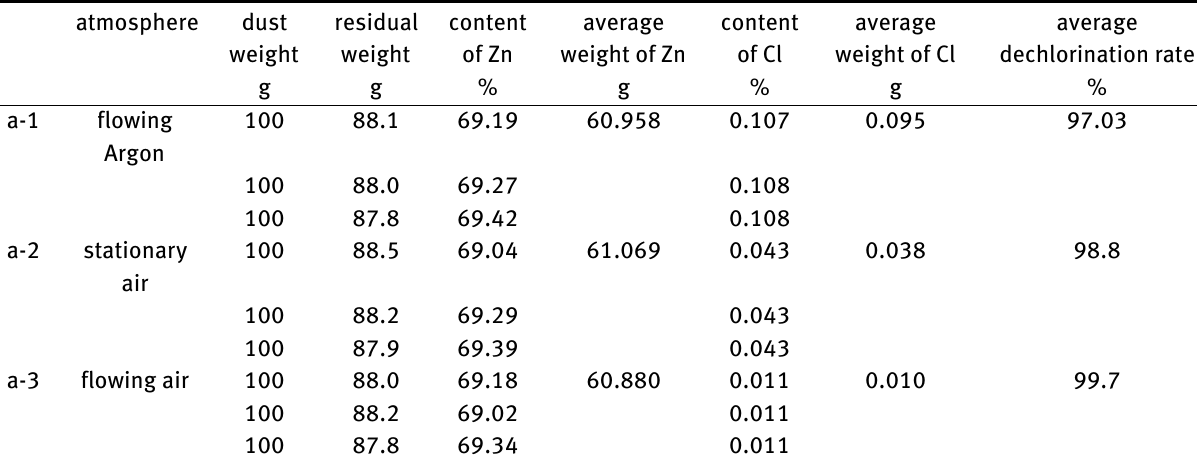
Table 5: Calculation of dechlorination and [Zn] reclaiming in experiment (a) involving in different atmosphere environments atmosphere dechlorination synchronous actual [Zn] loss Rate of [Zn] g dezincification g